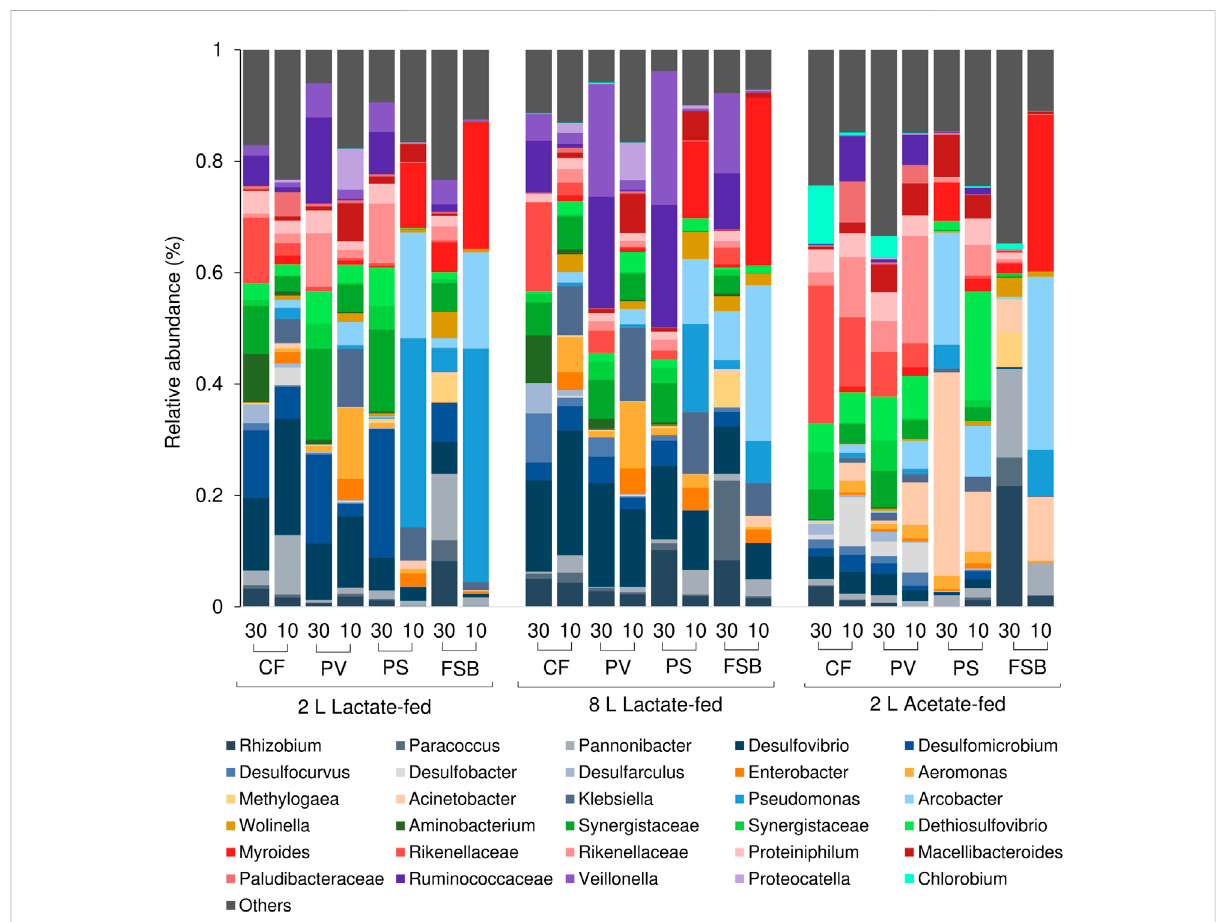
FIGURE 9 Taxonomic classi fi cation at genera level showing the compositional shift in relative abundance of dominant af fi liated sequences in the CF, PV, PS, and FSB microbial communities as a function of decreasing temperature from 30 to 10 ° C in the 2 L lactate-fed, 8 L lactate-fed and 2 L acetate- fed